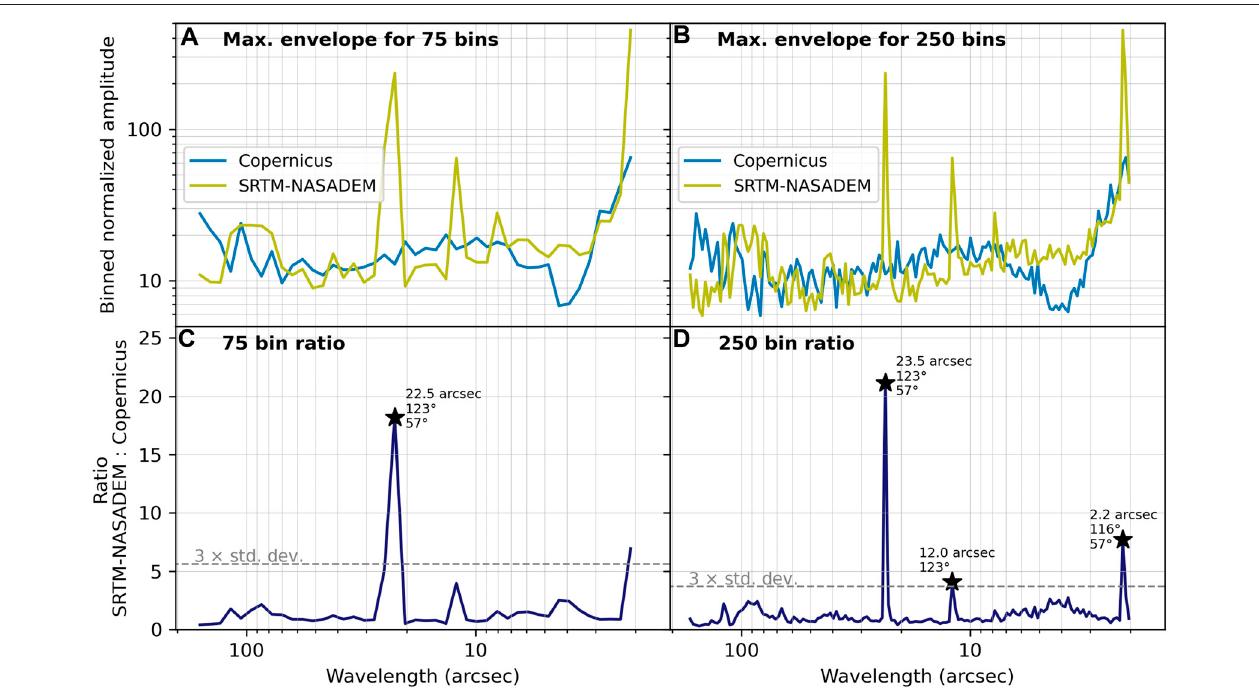
FIGURE 6 | Example 1D DFT peak fi nding procedure for the same 1 arcsec ∼ 60-km square SRTM-NASADEM tile shown in Figures 4 , 5 . The result for 75 bins is shown in (A) and (C) , and for 250 bins in (B) and (D) . The maximum HPHS power envelope from the same tile for Copernicus is used for normalization to highlight the anomalous peaks. The minimum and maximum wavelength for binning and peak identi fi cation is set to 2 and 165 arcsec ( ∼ 60 – 5,000 m), respectively. Peaks are automaticallyselectedintheratioplotiftheyare3 × thestandarddeviationandaboveavalueof2.Thewavelengthofthepeakisidenti fi ed,andtheorientationofthe maximum wavelength in degrees counter clockwise from east are found by searching for the maximum value in the associated 2D DFT plot at this wavelength ± 5%. Peaks are labelled with their wavelengths and orientations. Not all peaks are found, but the procedure is repeated for 41 bin numbers (50 – 250 in steps of 5) for fi tting uncertainty